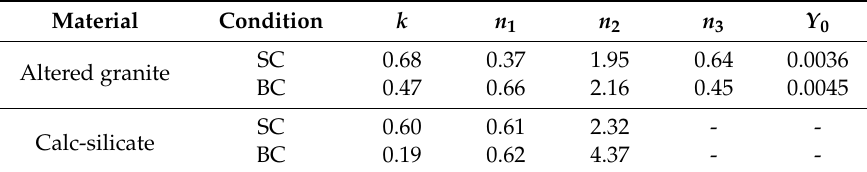
Table 3. Parameters of the breakage function used for simulation [22]. The values of k , n 1 , n 2 and n 3 are dimensionless, and Y 0 is in m. SC is the abbreviation for single particle compression, and BC is the abbreviation for bed particle